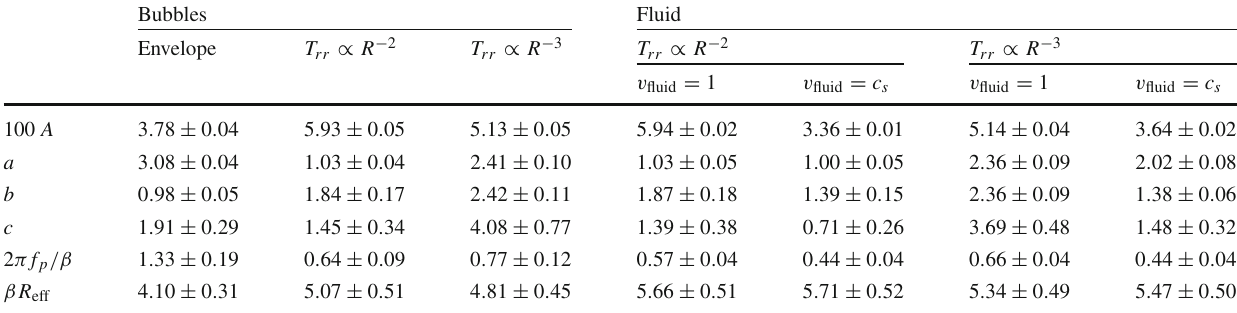
Taking into account that for very relativistic walls the fluid profiles are extremely peaked, we have thus show that the final GW spectrum will be indistinguishable from an even stronger transitionwherebubblecollisions wouldbethemain source. Only for weaker transitions where the hydrodynam- ical effects change the propagation speed of the fluid shells, the spectrum diverges from the spectrum arising from bubble